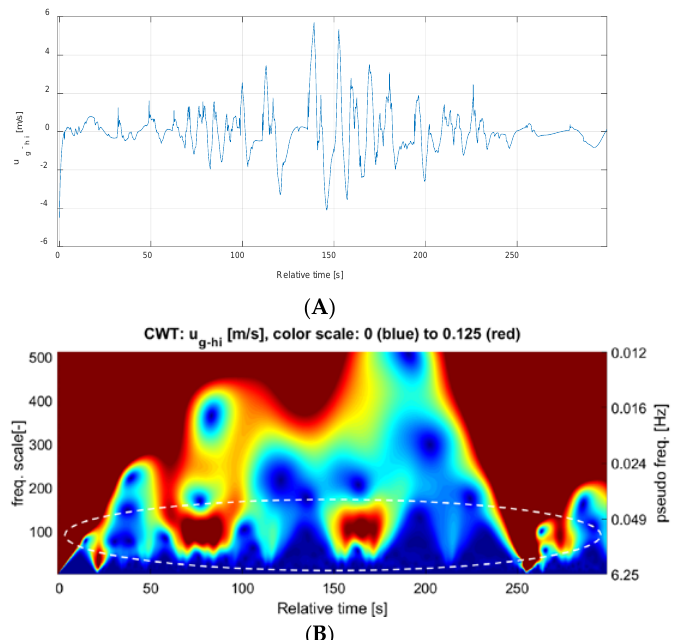
Figure 16. ( A ) Temporary change of frontal wind component estimation ( U g-hi ) based on Equation (12); ( B ) continuous wavelet analysis of data from ( A ).